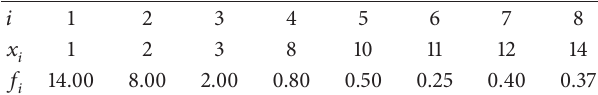
Table 2: Positive dataset given in